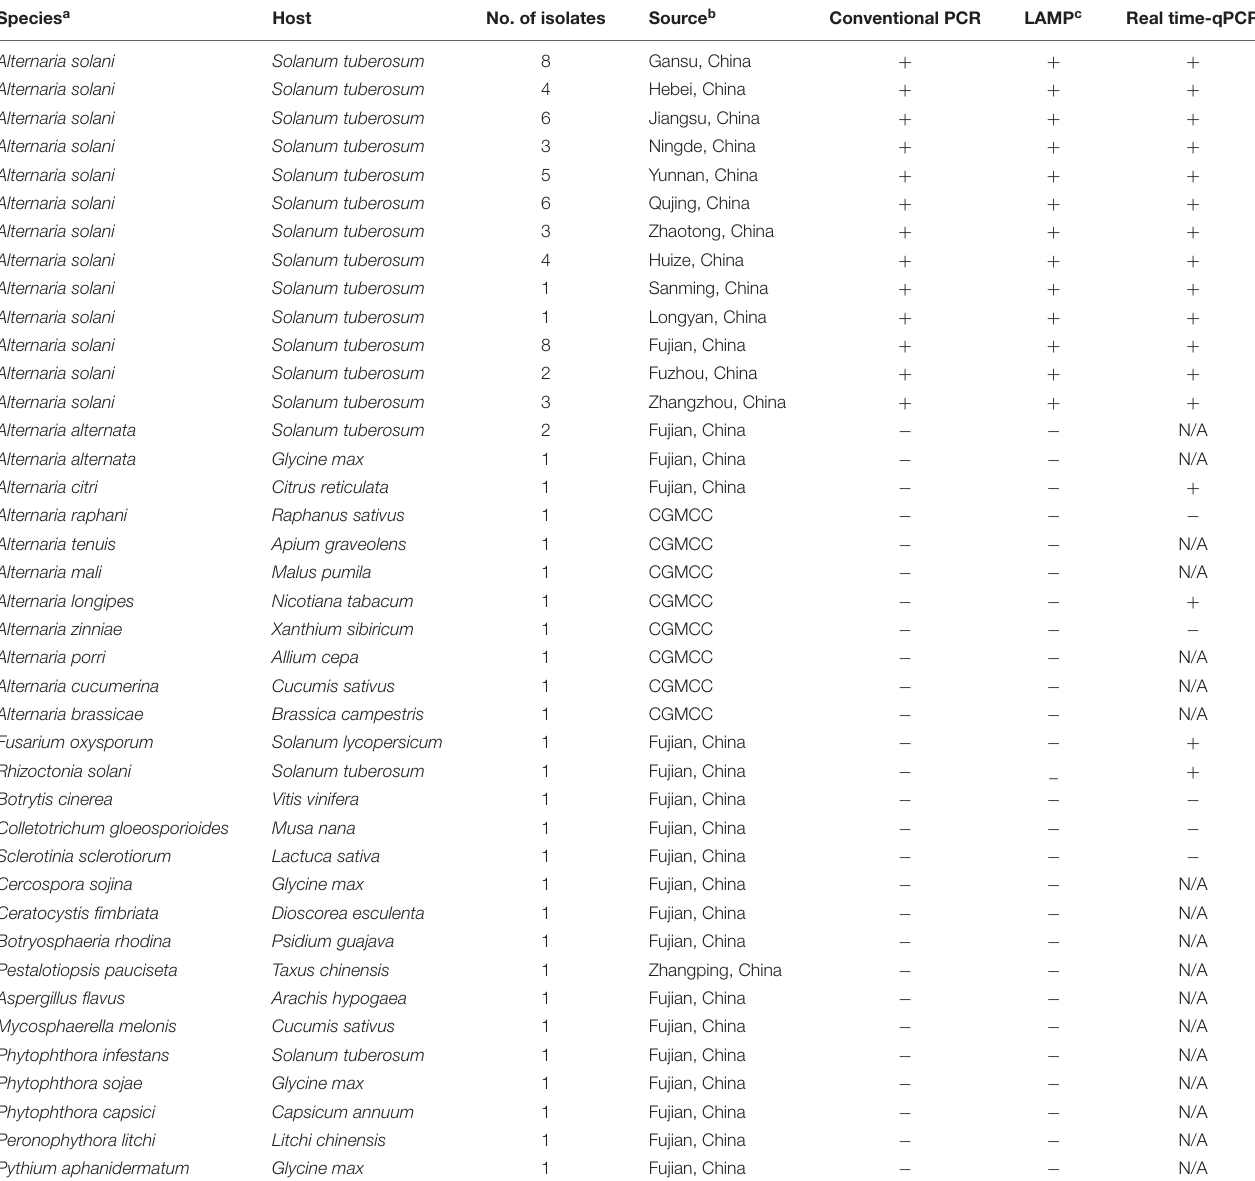
TABLE 1 | Fungal isolates used in this